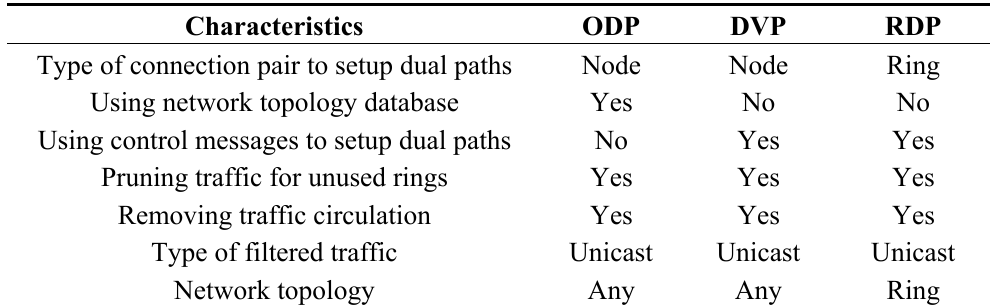
Table 4. Characteristics of predefined path-based